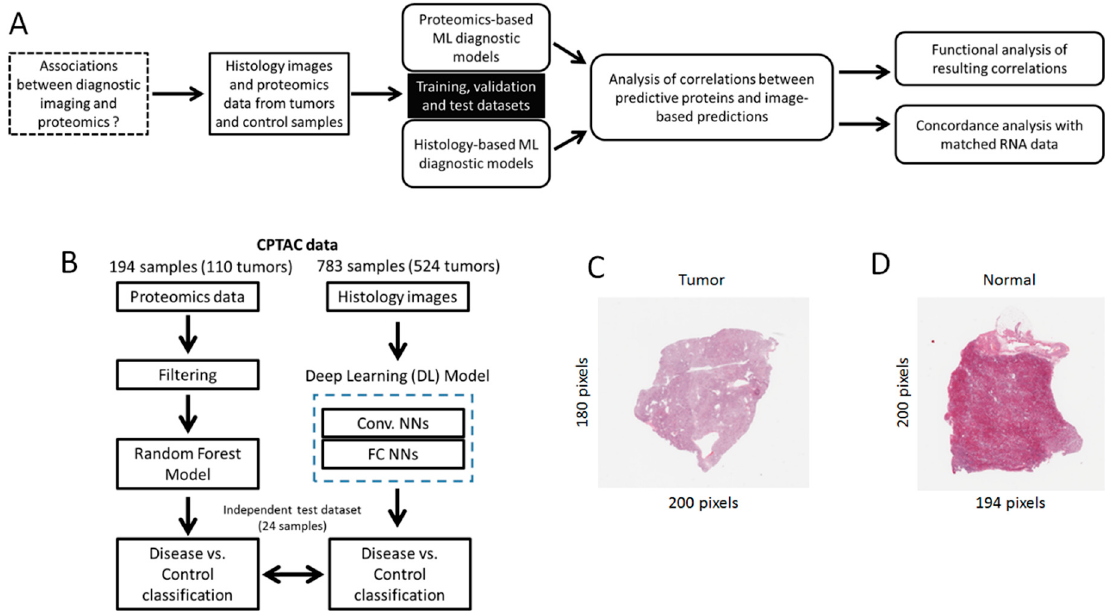
Figure 1. Overview of research strategy. ( A ) Analytical and predictive modeling workflow implemented in this study. ( B ) Focus on the implementation of diagnostic models based on proteomics and histology imaging. ( C, D ) Examples of histology (thumbnail) images obtained from tumor and normal samples respectively.